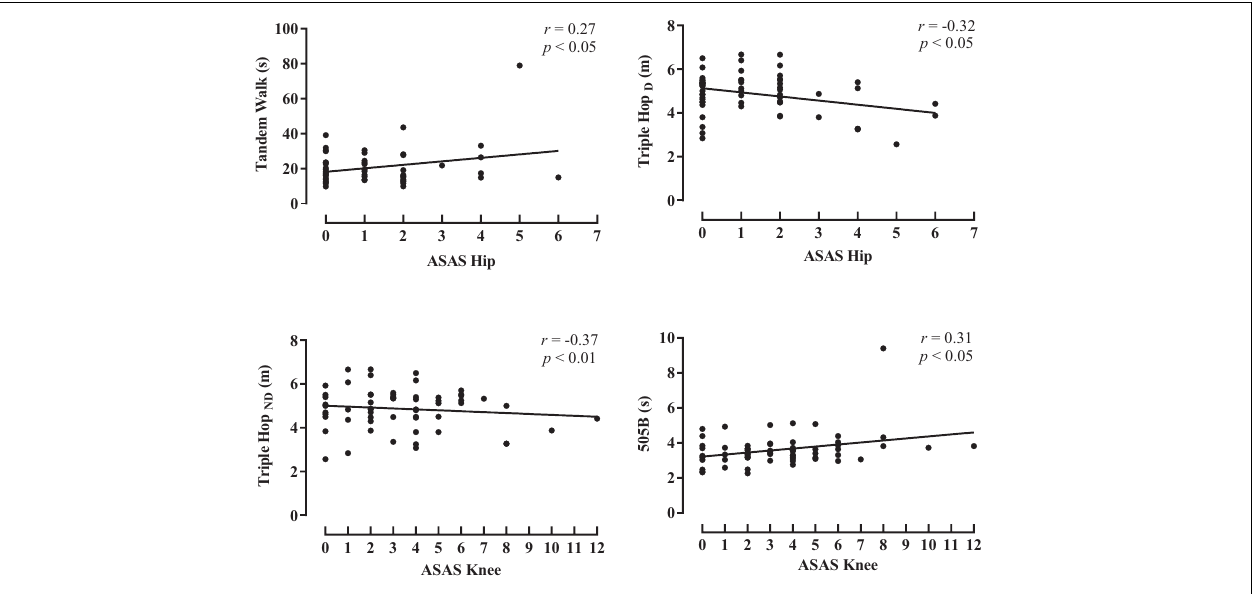
FIGURE 1 | Pearson product correlation between scores for the Australian Spasticity Assessment Scale (ASAS) in hip and knee muscle groups and activity limitation test performance by all para-footballers. TW, tandem walk, TH D , triple hop for distance dominant leg; TH ND , triple hop for distance non-dominant leg; 505B, 505 agility test with